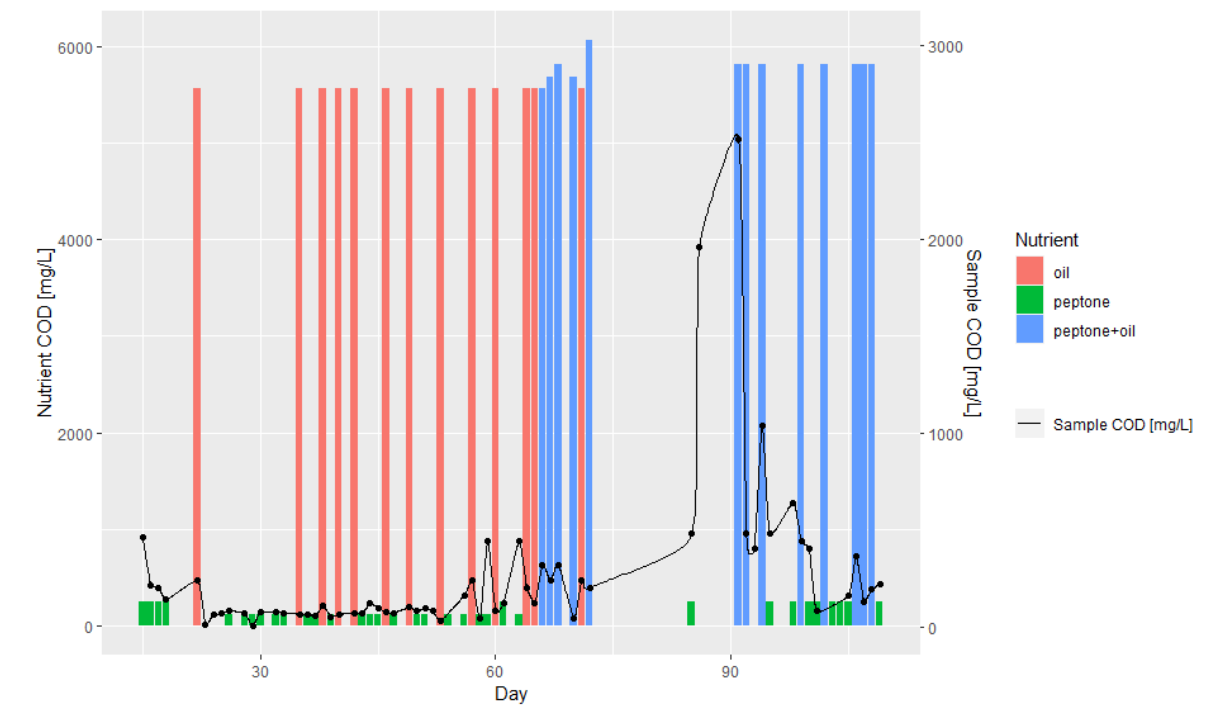
Figure 4. Relationship in time between chemical oxygen demand, nutrient medium, and filtered sample from the batch bioreactor.